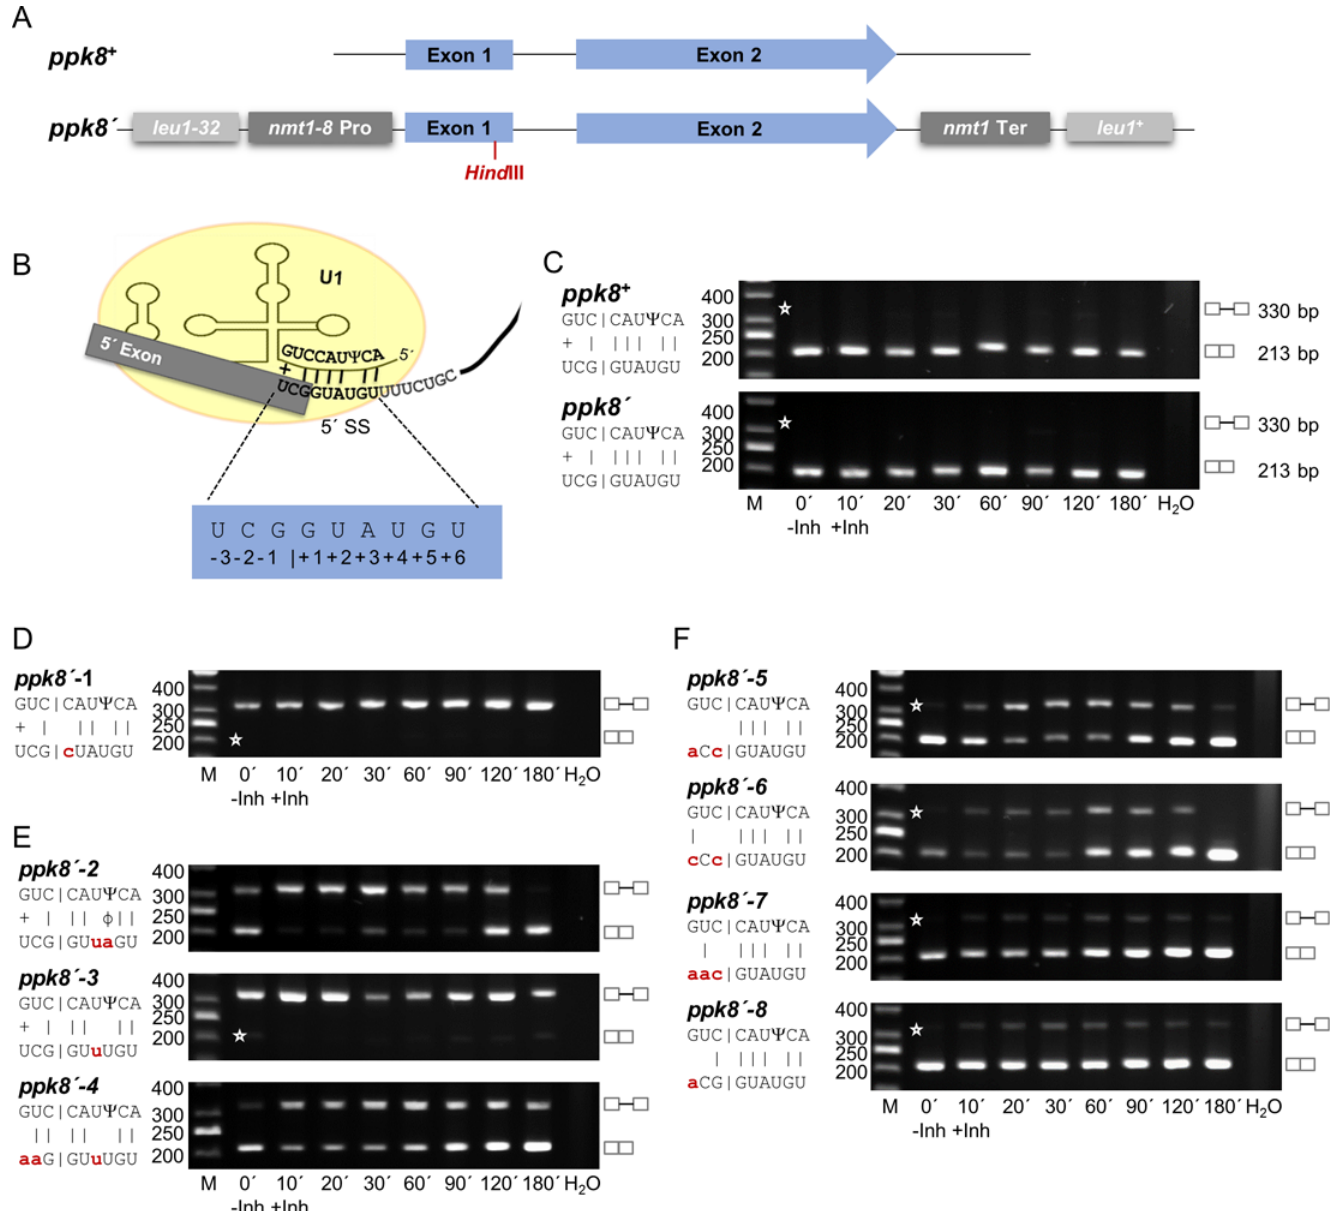
Fig 4. The Prp4 kinase independence of the ppk8 intron can be changed by mutations in the exon1/5 ’ splice site. (A) Schematic representation of the ppk8 + and ppk8 ’ genes. The ppk8 ’ gene was integrated by homologous recombination into the leu1 locus. All strains containing a ppk8 ’ gene also contain ppk8 + . (B) Proposed base-pairing between the ppk8 + exon1/5 ’ SS region and snRNA U1. Ψ indicates the pseudouridine 3 nucleotides from the 5 ’ end of snRNA U1. Numbering of the exon1/5 ’ SS region is indicated. (C – F) RT-PCR analysis in the absence (-Inh) and presence (+Inh) of inhibitor at the times indicated in minutes. H 2 O, negative control without template. The scheme on the left side of the image shows the details of the interactions between exon1/5 ’ SS and snRNA U1. Small letters indicate the mutations in ppk8 ’ exon1/5 ’ SS; the corresponding alleles were named as indicated. |, Watson-Crick base- pairing; +, wobble base-pairing G-U; Ψ , Pseudouridine; ϕ , wobble base-pairing Ψ -A. Asterisks indicate the expected position of fragments if the introns are or are not spliced out. The numbers on the left side of the image represent the sizes of the DNA fragments (bp). M, DNA size marker. C compares endogenous ppk8 + with integrated ppk8 ’